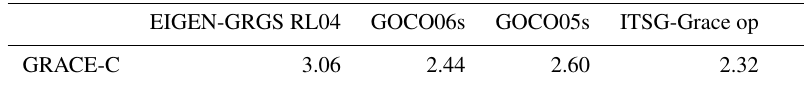
Table 5. Root mean square of differences between integrated dynamic orbit and GPS-derived kinematic positions for GRACE-C in January 2020 in